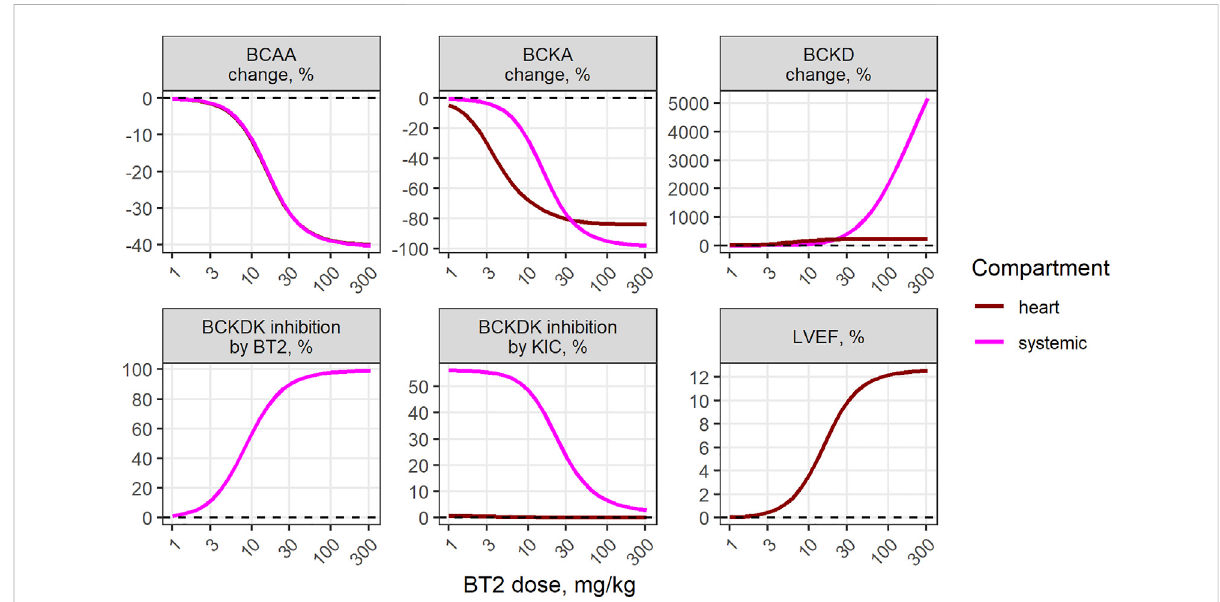
FIGURE 3 Model-predicted dose-dependent BT2 effect on various markers of BCAA catabolism in the systemic circulation and the cardiac